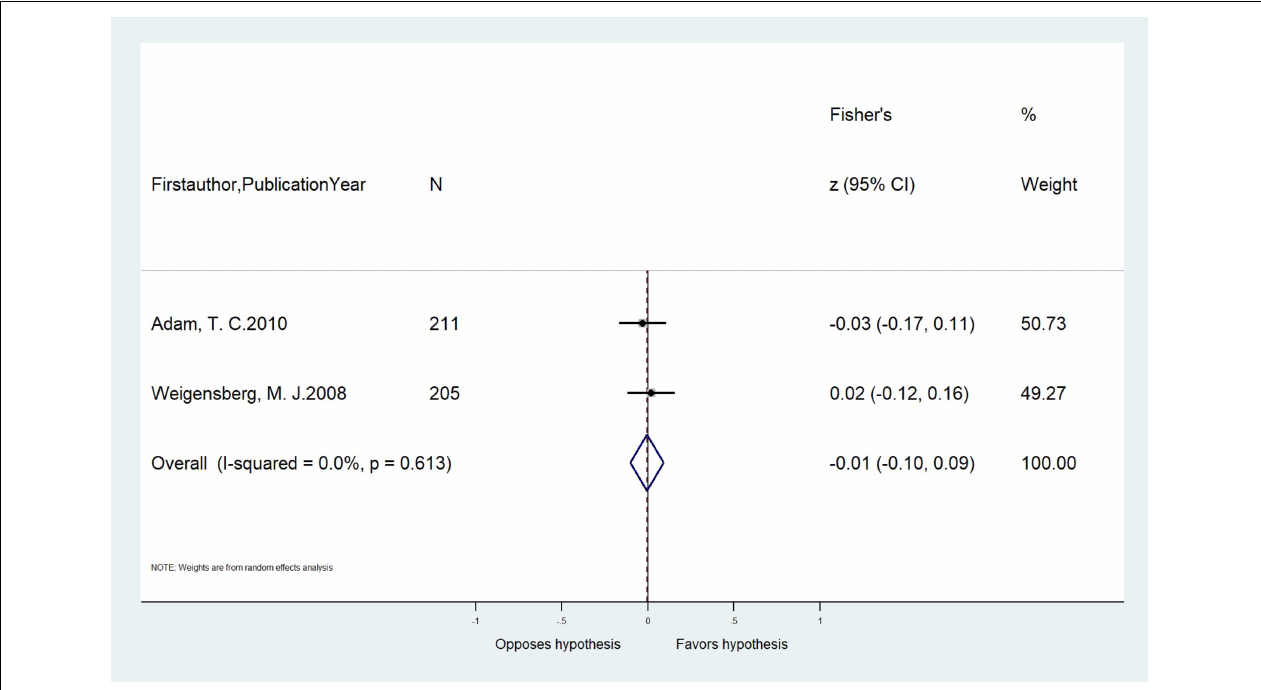
FIGURE 4 | Meta-analysis of the unadjusted correlations ( r , 95% CI) between serum cortisol concentration and waist circumference in cross-sectional studies ( n = 2).